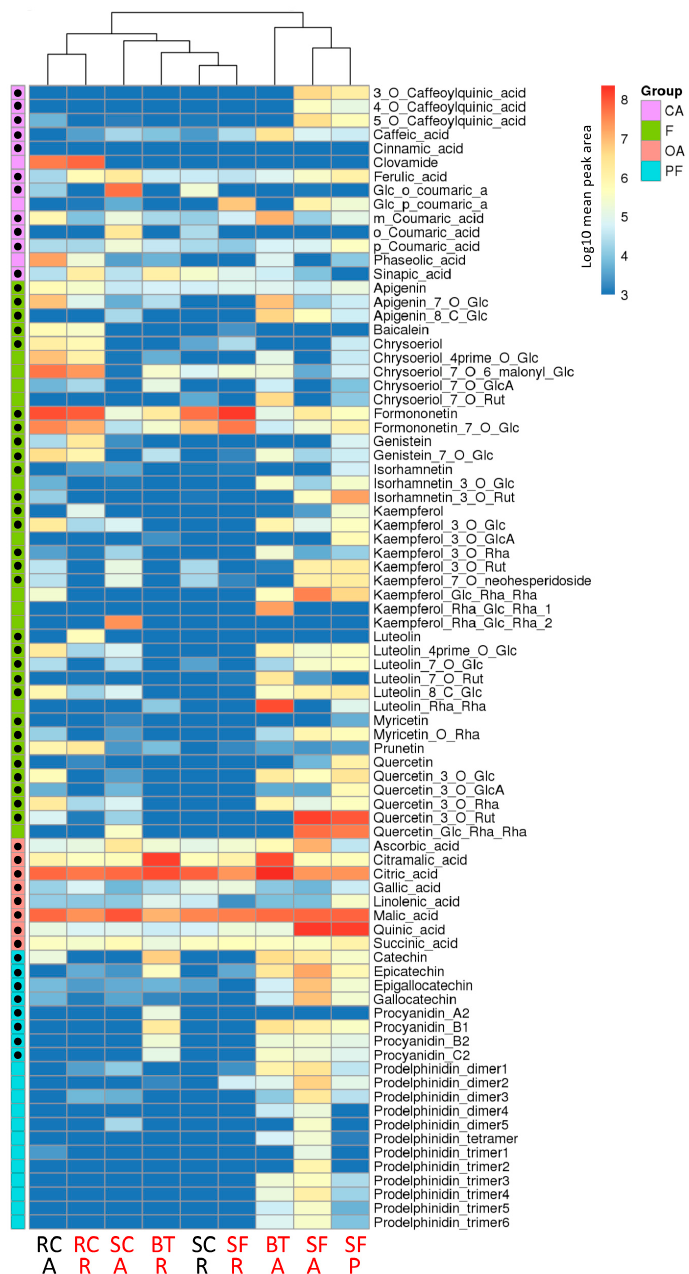
Figure 2. Metabolic profiling of Fabaceae extracts. Log10 mean peak areas of the indicated metabolites are given by shades of red, yellow or blue colors according to the scale bar. Metabolites are grouped as cinnamic acid and derivatives (CA), flavonoids (F), organic acids (OA) and proanthocyanidins and flavanols (PF). Identity of the metabolites indicated with black dots was confirmed with the corresponding standard. SF: sainfoin, BT: birdsfoot trefoil, RC: red clover, SC: sweet clover, A: aerial parts, R: roots, P: pellets. Weakly nematicidal and highly nematicidal extracts are indicated in black and red, respectively. Hierarchical clustering highlights similarity among samples. For glycosides, the following abbreviations were used: glucoside: Glc; glucuronide: GlcA; rhamnoside: Rha; rutinoside: